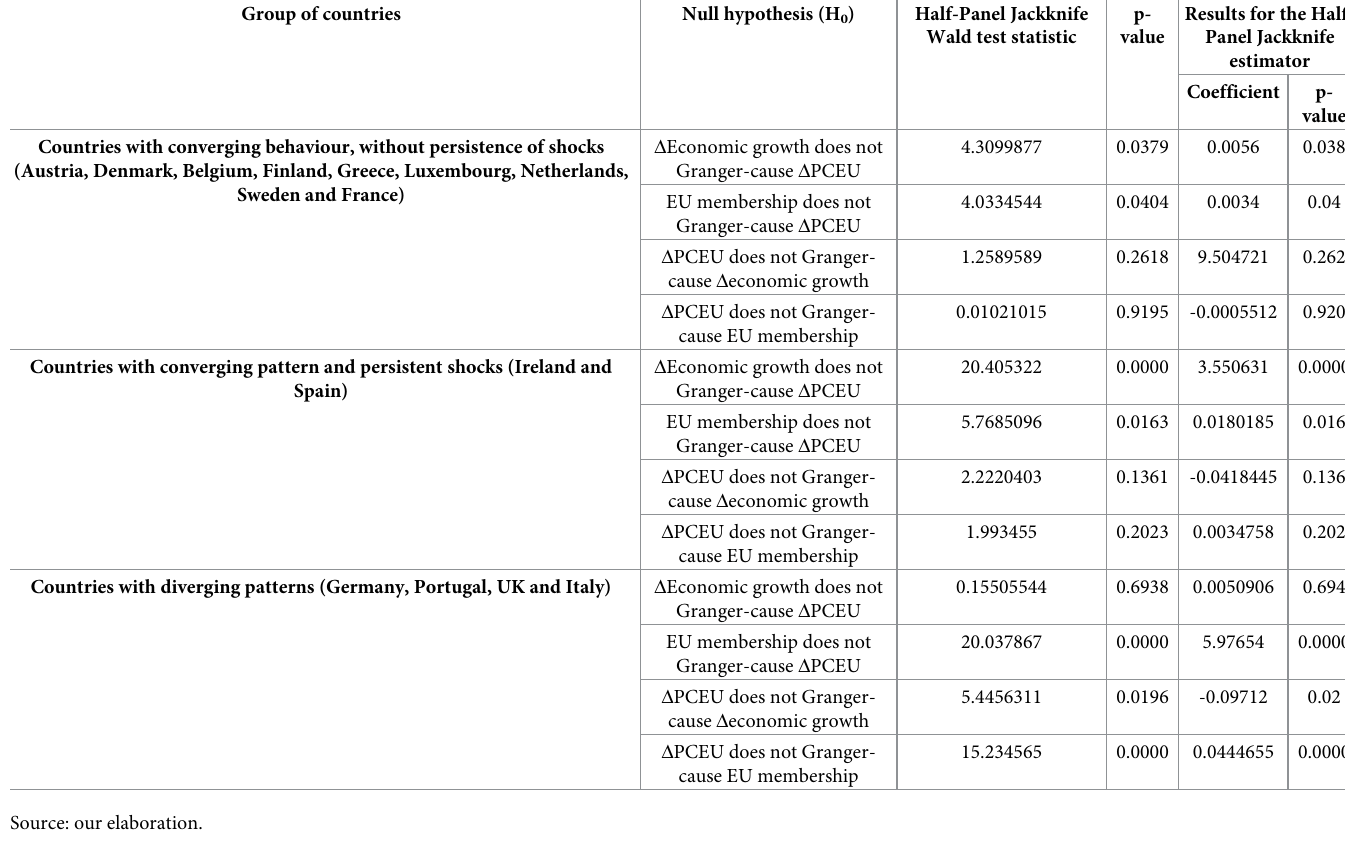
Table 9. Results of the panel Juodis, Karavias and Sarafidis (JKS, 2021) causality test for EU-15 countries (1970–2018). Group of countries Null hypothesis (H 0 ) Half-Panel Jackknife